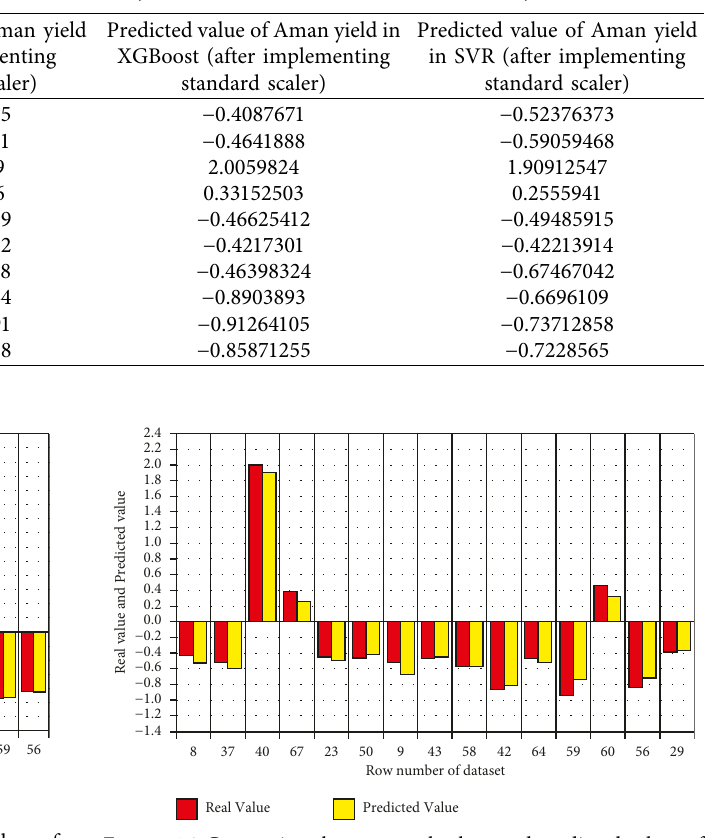
Figure 16: Comparison between real values and predicted values of Aman yield for SVR.